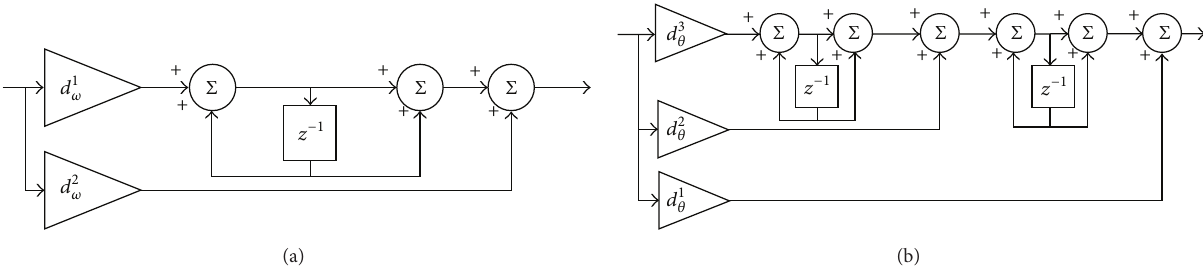
Figure 2: Block diagrams of (a) second- and (b) third-order digital loop filters excluding last integrator (the